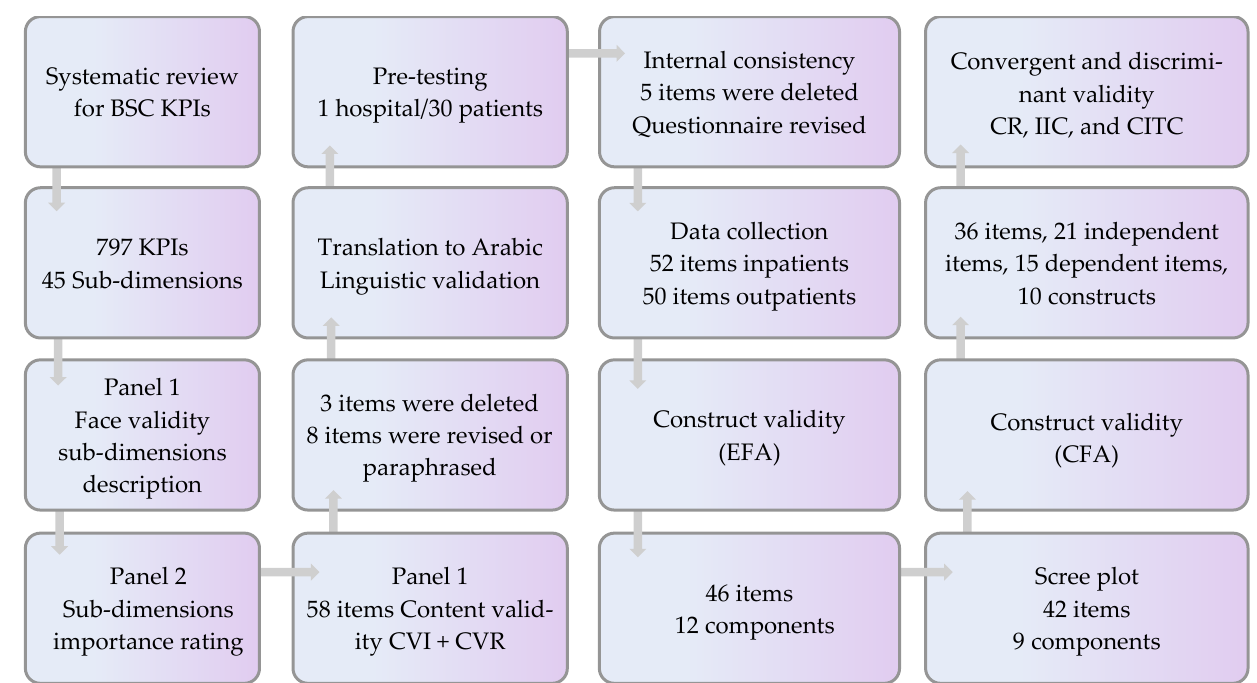
Figure 5. Flow chart for BSC-PATIENT development and psychometric validation. Error in